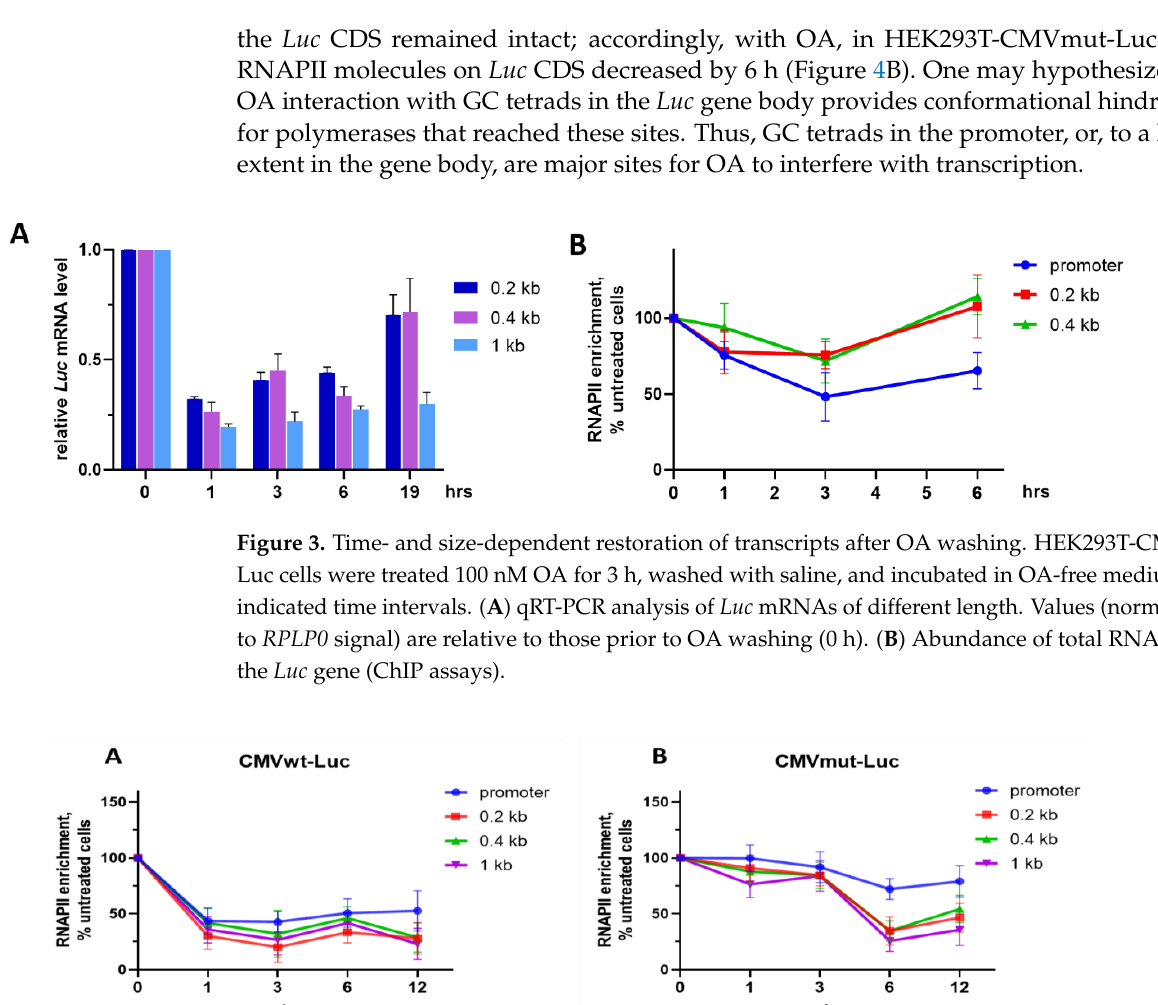
Figure 4. OA modulates the abundance of molecules depending on promoter GC context. HEK293T- CMVwt-Luc ( A ) or HEK293T-CMVmut-Luc ( B ) cells were treated with 100 nM OA for indicated time intervals followed by ChIP assays (see Section 3). Shown are enrichments in total RNAPII molecules on the Luc promoter and on CDS. RNAPII enrichment in untreated samples (0 h, input) was taken as 100%. Data are mean ± SD of two independent experiments, each value measured in triplicate.